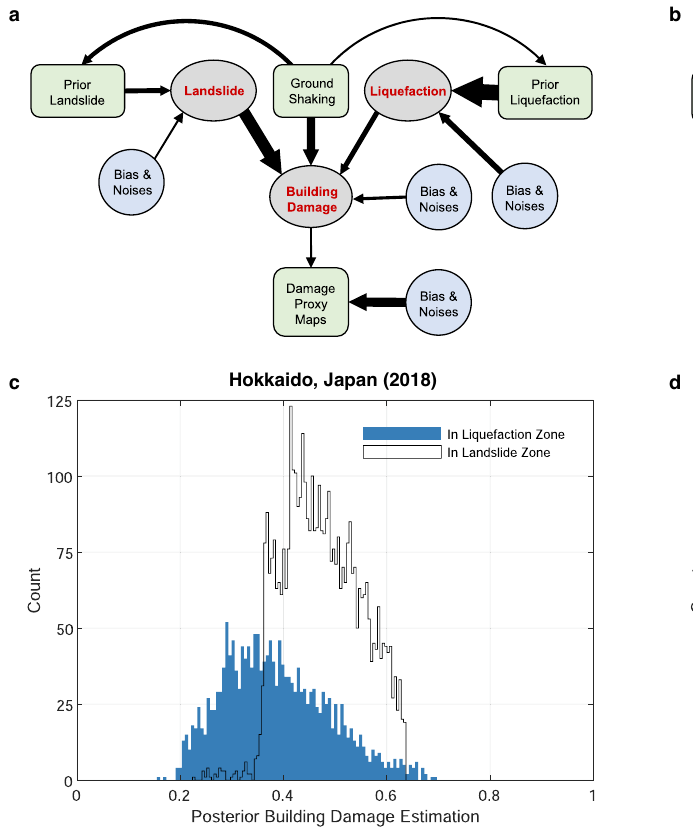
Fig. 5 | Analysis of causal mechanisms revealed by the graph. a Visualization of quanti fi ed causalgraph forthe 2018 Hokkaido, Japanearthquake. The thickness of each edge represents quanti fi ed importance of causal effect over the edge. b Visualizationofquanti fi edcausalgraphforthe2020PuertoRicoearthquake.The thickness of each edge represents quanti fi ed importance of causal effect over the